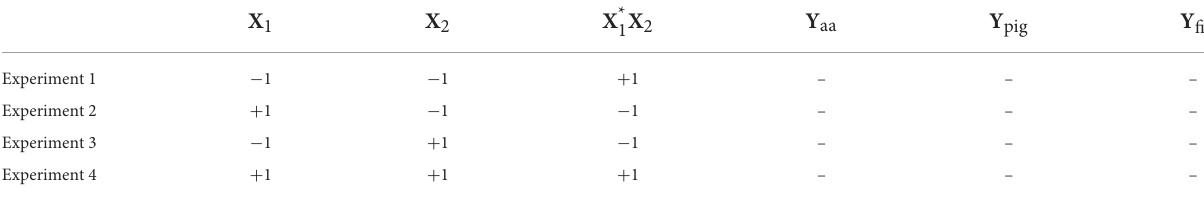
TABLE 2 Experimental design developed to study the effects of factors (X 1 : acetic acid and X 2 : chitosan) and their interaction (X * 1 X 2 ) on the shelf life extension of strawberries. X